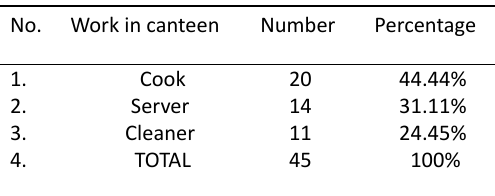
Table 1. Distribution of food handlers included in